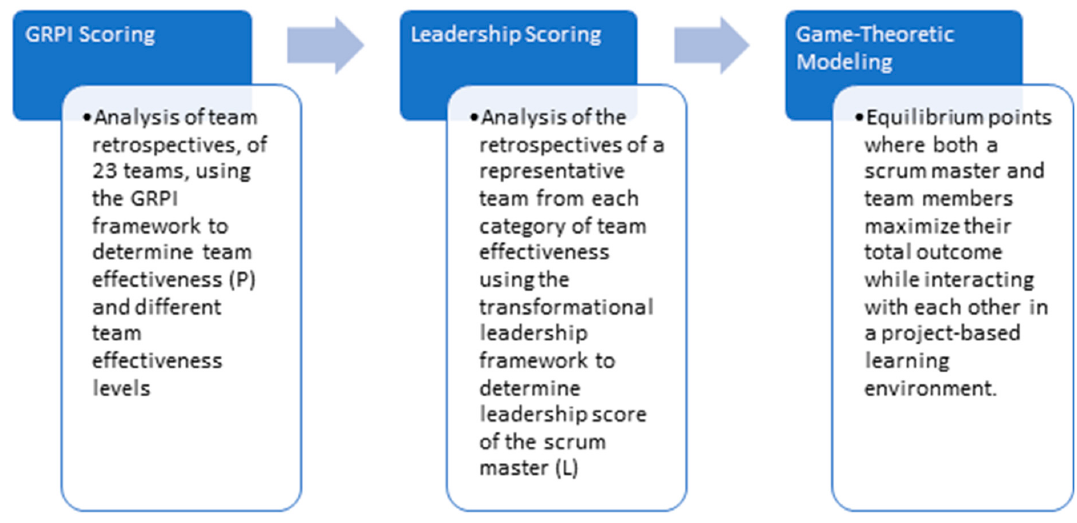
Figure 3. Data scoring and analysis flow-chart detailing the steps at each stage.